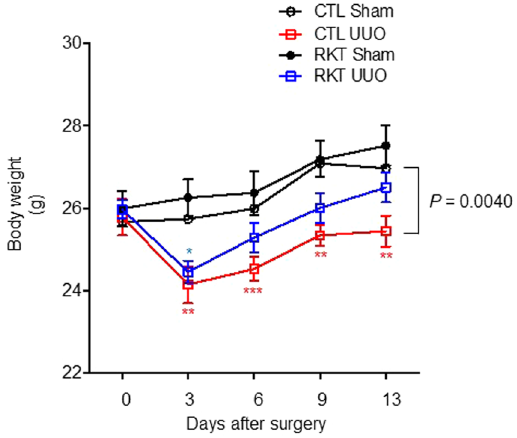
Figure 5. Effects of Rikkunshito treatment on body weight gain in sham- and UUO-operated mice. Values are expressed as mean ± SE (n = 6 per group). Differences in body weight among the four groups over time were analysed by two-way repeated measures ANOVA with Bonferroni’s post-test. * P < 0.05 vs sham-operated group fed a diet containing Rikkunshito. ** P < 0.01, *** P < 0.001 vs sham-operated group fed a standard diet. CTL, control standard diet; RKT, diet containing Rikkunshito; UUO, unilateral ureteral